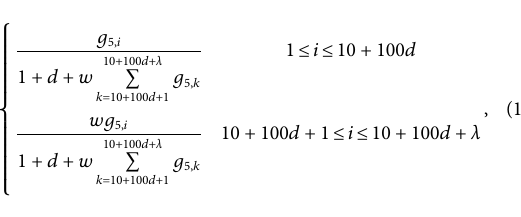
Frontiers in Genetics |